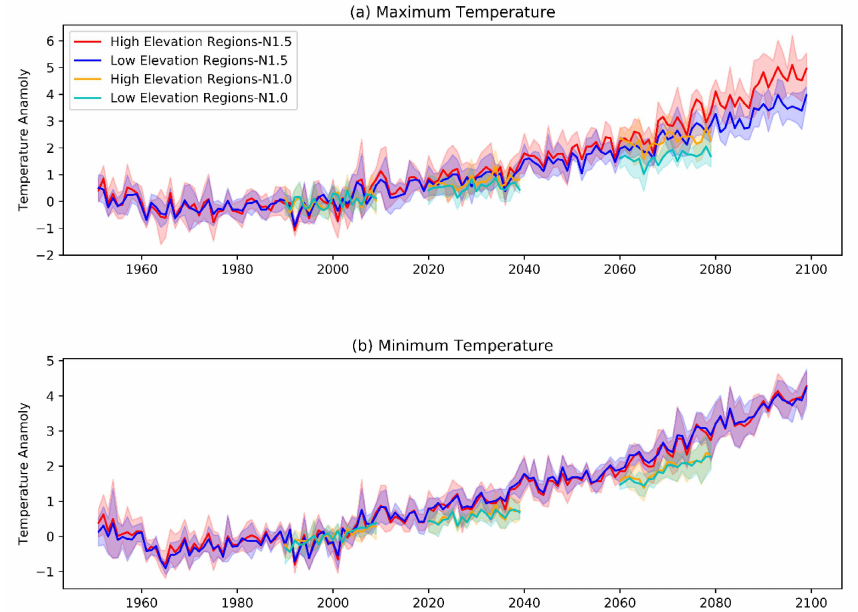
Figure 6. Time series (from 1951–2099) of maximum and minimum temperatures anomalies (cal- culated with respect to 1990–2009) for high and low elevation for N1.0 and N1.5. Here red and blue solid lines denote the ensemble mean of NARCliM1.5 (N1.5) simulations for high and low elevation respectively, brown, and green solid lines represent the ensemble mean of NARCliM (N1.0) simulations for high and low elevation respectively. The shading denotes the max and min across the ensemble